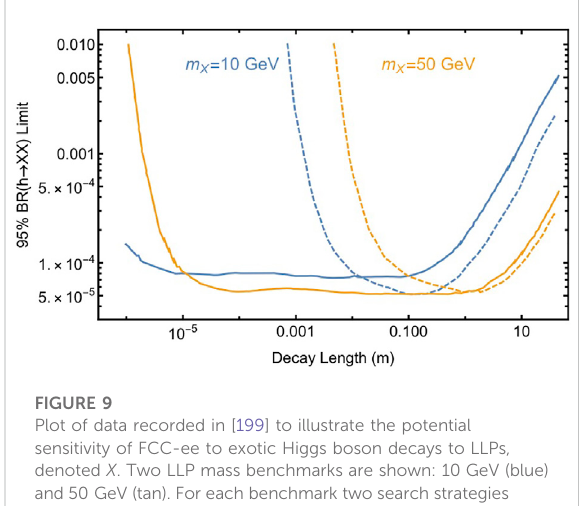
FIGURE 9 Plot of data recorded in [199] to illustrate the potential sensitivity of FCC-ee to exotic Higgs boson decays to LLPs, denoted X . Two LLP mass benchmarks are shown: 10 GeV (blue) and 50 GeV (tan). For each benchmark two search strategies are presented. The solid line employs an invariant mass cut to improve sensitivity at shorter decay lengths, the dashed line relies on longer decay lengths to reduce SM